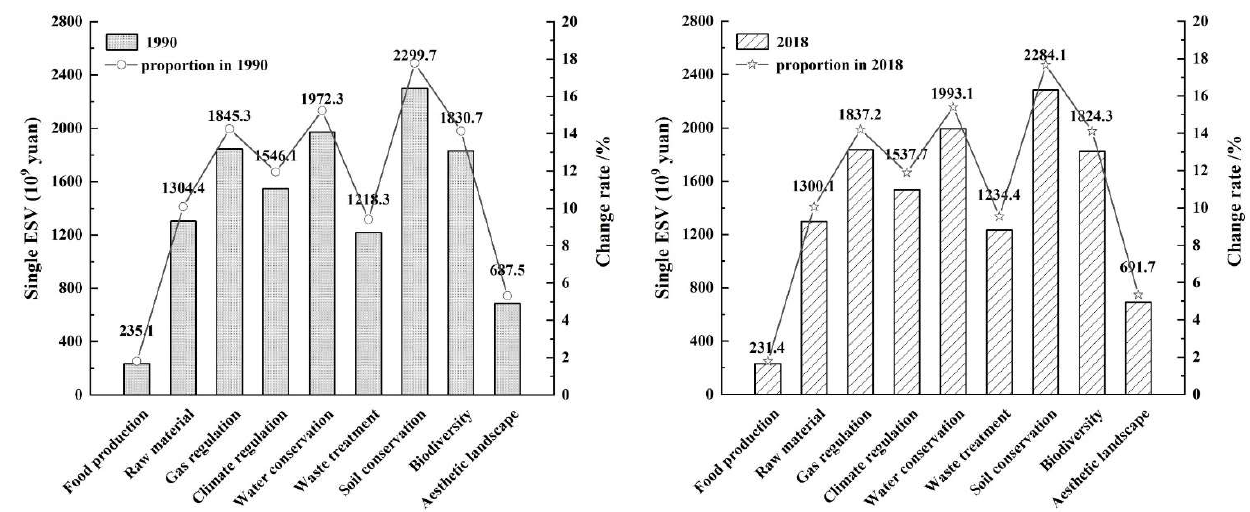
Figure 5. Single ESV of Guangxi in 1990 and